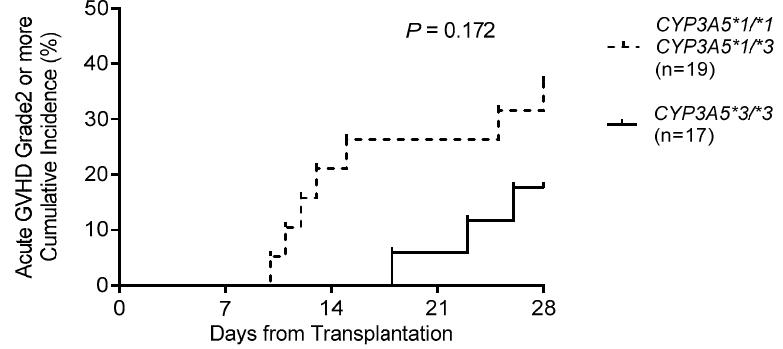
Figure 1. Cumulative incidence of grade II–IV acute graft-versus-host disease (GVHD) according to CYP3A5 genotype during the first four weeks following HSCT. Cumulative incidence is plotted from the day of stem cell transplantation (day 0), with curves for each genotypic variant.